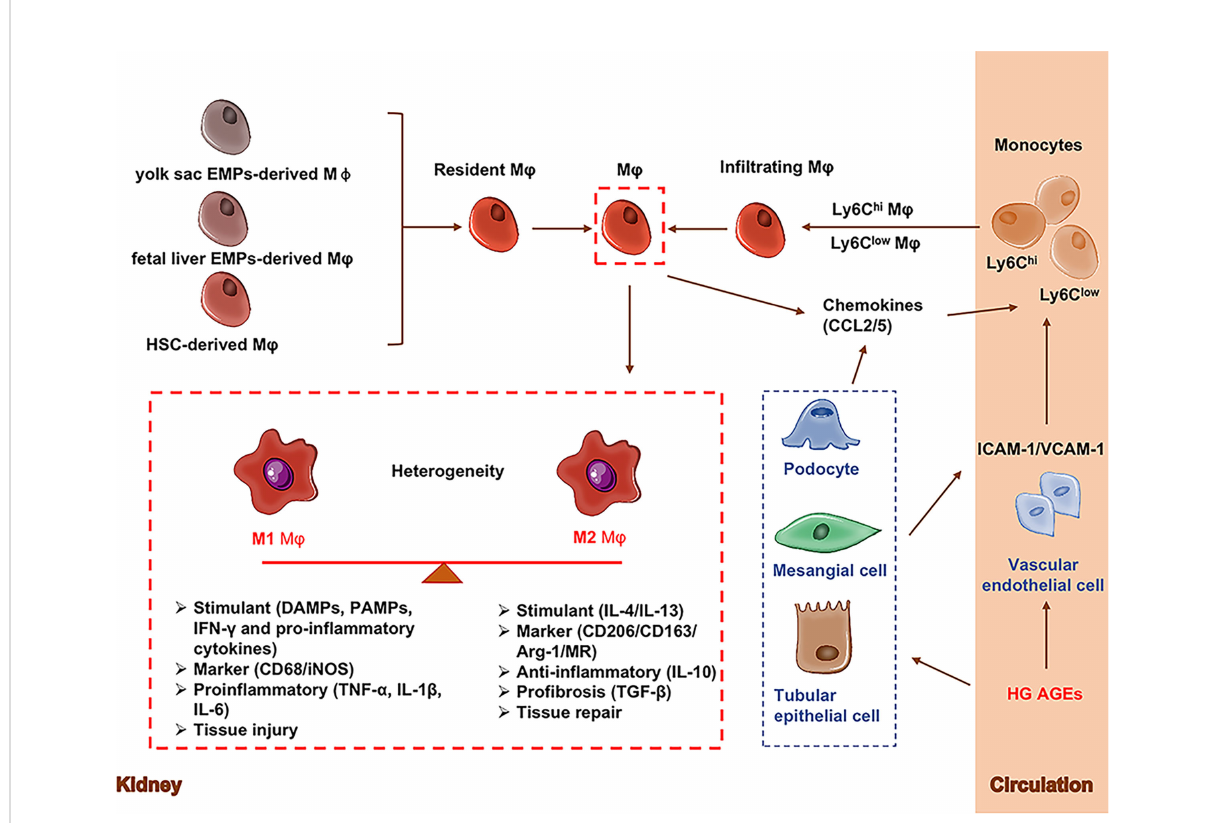
FIGURE 1 Origins and phenotypes of macrophages. Renal macrophages (M j ) are consisting of resident macrophages and in fi ltrating macrophages. Resident macrophages mainly have three sources including yolk sac-derived erythro-myeloid progenitors (EMPs)-derived M j , fetal liver EMP- derived M j , and hematopoietic stem cell (HSC)-derived M j . During the initial stages of kidney injury, resident macrophages act as gatekeepers to initiate or suppress immune responses. Actived resigent M j and kidney cells release chemokines/cytokines to recruit circulating monocytes to kidney tissuse (called in fi ltrating macrophages). Macrophages are generally classi fi ed into classic M1 and alternative M2 macrophages. M1 macrophages (CD68/iNOS) express and secrete in fl ammatory cytokines (TNF- a , IL-1 b , IL-6) and promote tissue in fl ammation. M2 macrophages (CD206/CD163/Arg-1/MR) secrete anti-in fl ammatory (IL-10) and pro- fi brotic cytokines (TGF- b ) that promote tissue repair and fi brosis. Arg-1, Arginase-1; EMPs, Erythro-myeloid progenitors; CCL2, C-C Motif chemokine ligand 2; HSC, Hematopoietic stem cell; ICAM-1, Intercellular adhesion molecule-1; MR, Mannose receptor; M j , Macrophages; VCAM-1, Vascular cell adhesion molecule-1; VECs, Vascular endothelial